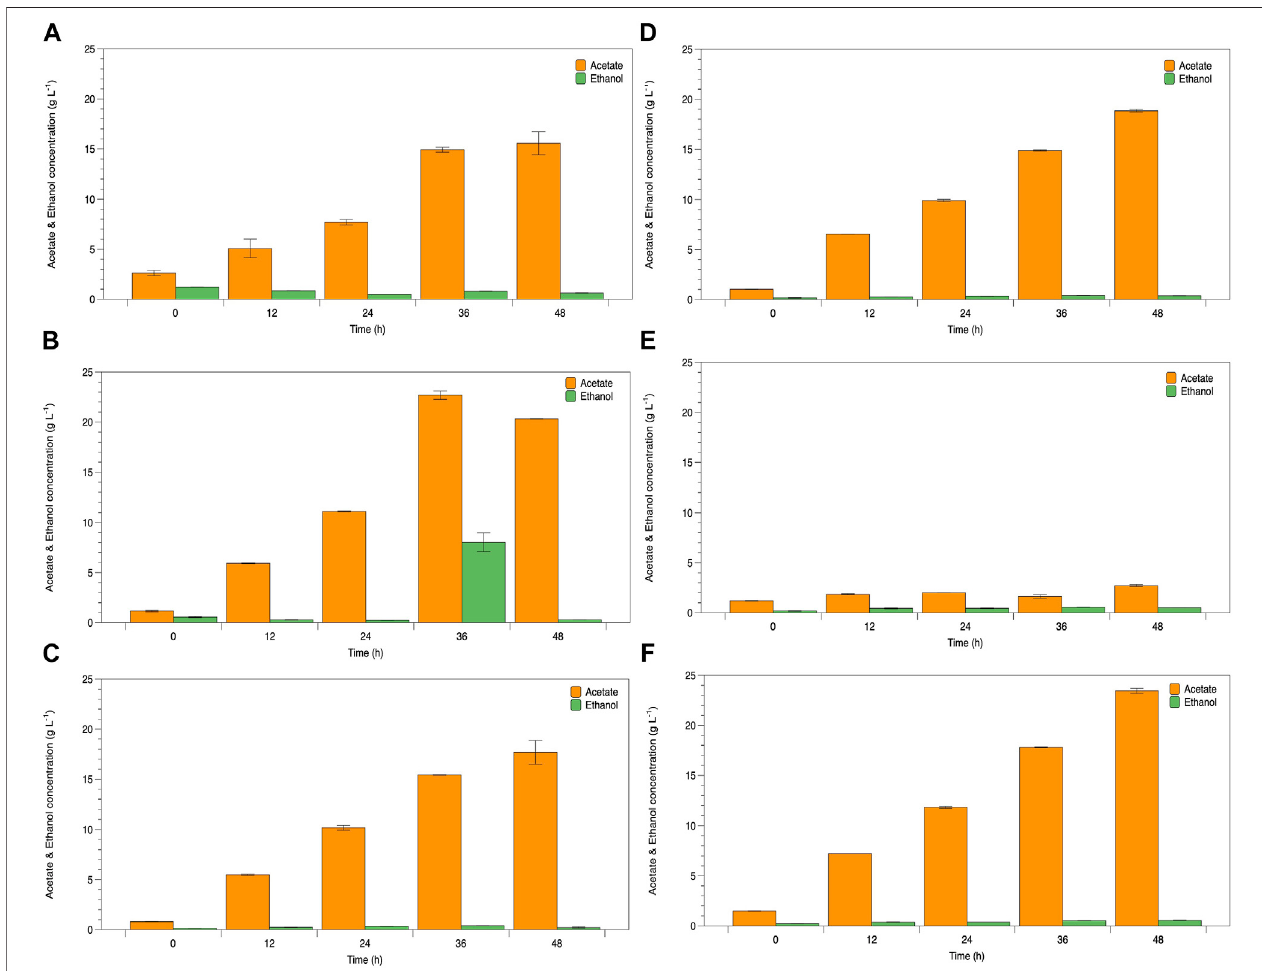
FIGURE 2 | Time course of B. coagulans ATCC 7050 growth and acetate and ethanol production under various conditions as (A) control, (B) WCR 20 g L − 1 , (C) WCR 40 g L − 1 , (D) WCR 60 g L − 1 , (E) WCR 80 g L − 1 , and (F) 100 g L − 1 . All values are represented as means (±SD).